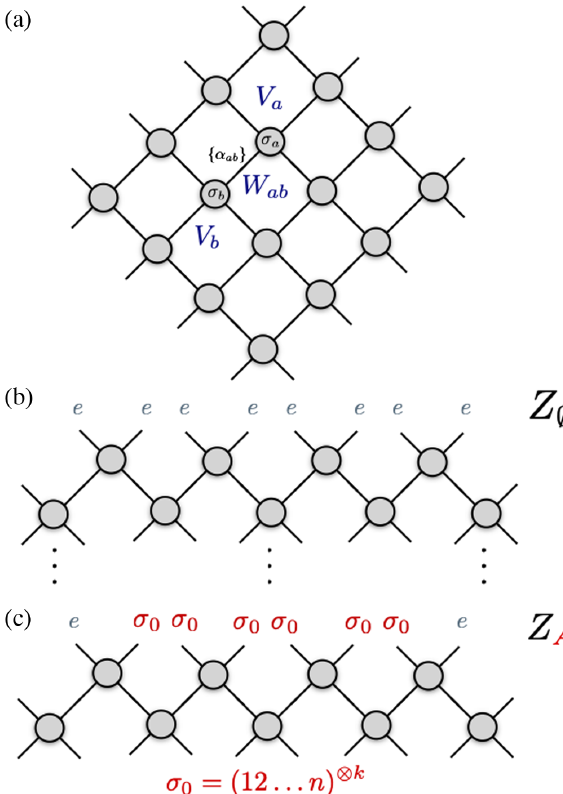
FIG. 11. Replicated statistical mechanics model. (a) The re- plicated statistical model is defined on a tilted square lattice, with ∈ S permutation degrees of freedom σ living on vertices, and a Q charge degrees of freedom f α i g . The Boltzmann weights i ¼ 1 ; … ;Q have contributions from both vertices V , see Eq. (A10), and a links W , Eq. (A9). (b) Fixed boundary conditions in Z ∅ at the ab top layer (ending the circuit at a given time t ), with all permutations fixed to e . (c) The partition function Z differs A from Z ∅ by the boundary condition fixed to σ 0 in the entangle- ment interval A . This creates a domain wall that follows a minimal cut in the limit d → ∞